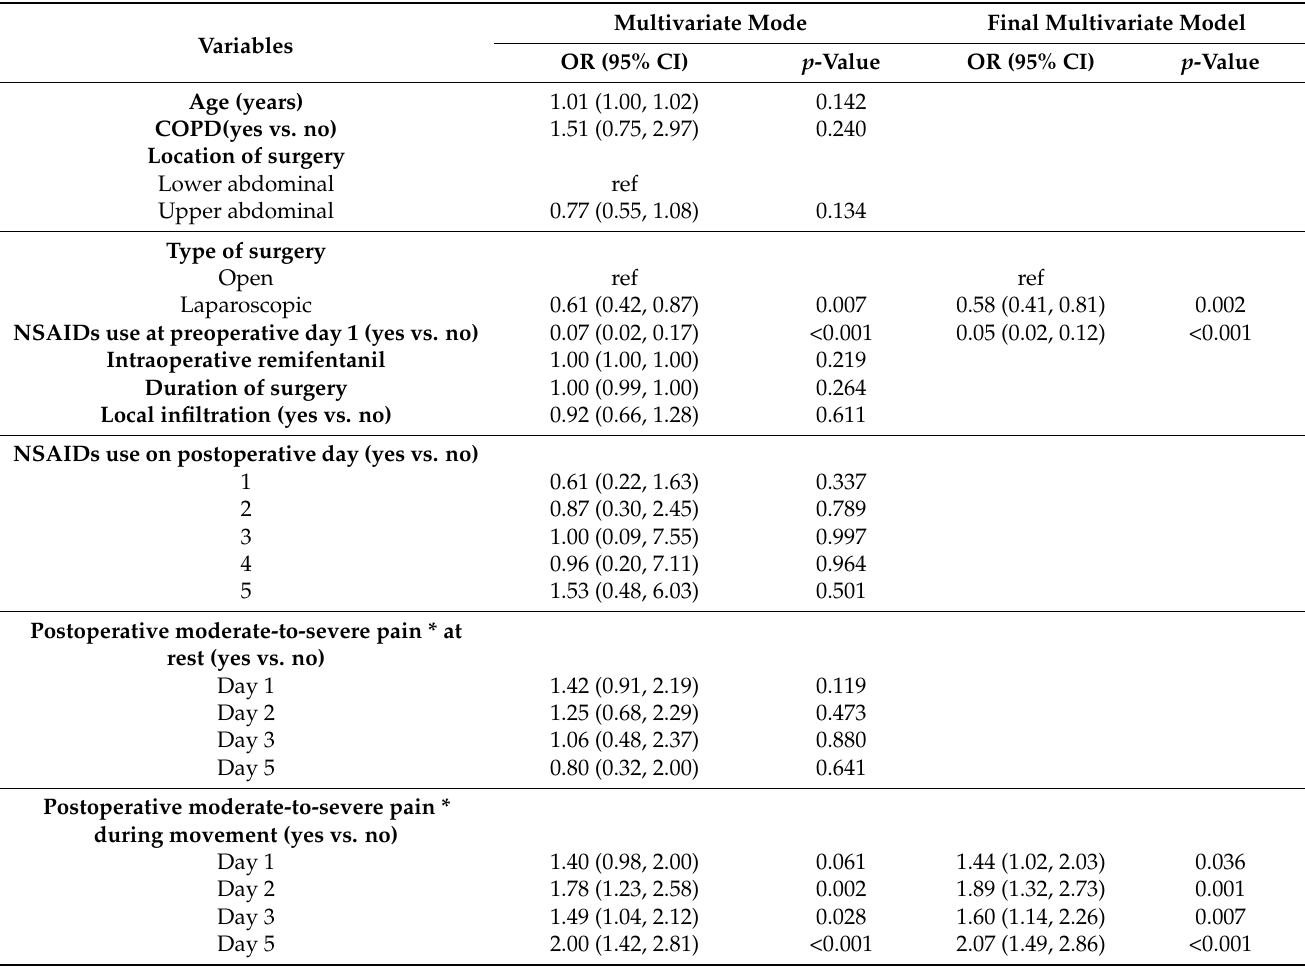
Table 3. Univariable and multivariable results based on the logistic model for identifying risk factors for “high-intensity” opioid